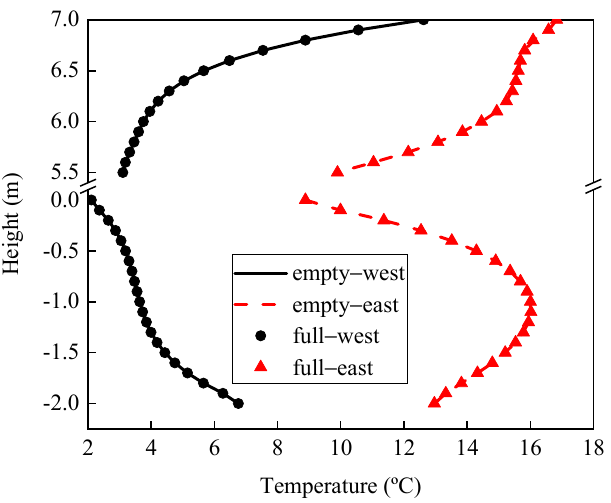
Figure 18. Vertical temperature gradients of the surfaces B and C in winter.